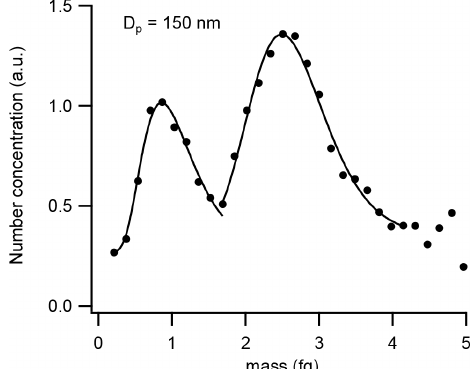
Figure 5. Measured DMA–APM spectrum for urban particles with a diameter of 150nm (black markers). The spectrum is the aver- age number concentration (arbitrary units) of 11 samples from all sampling days. Two lognormal fits are shown in black.